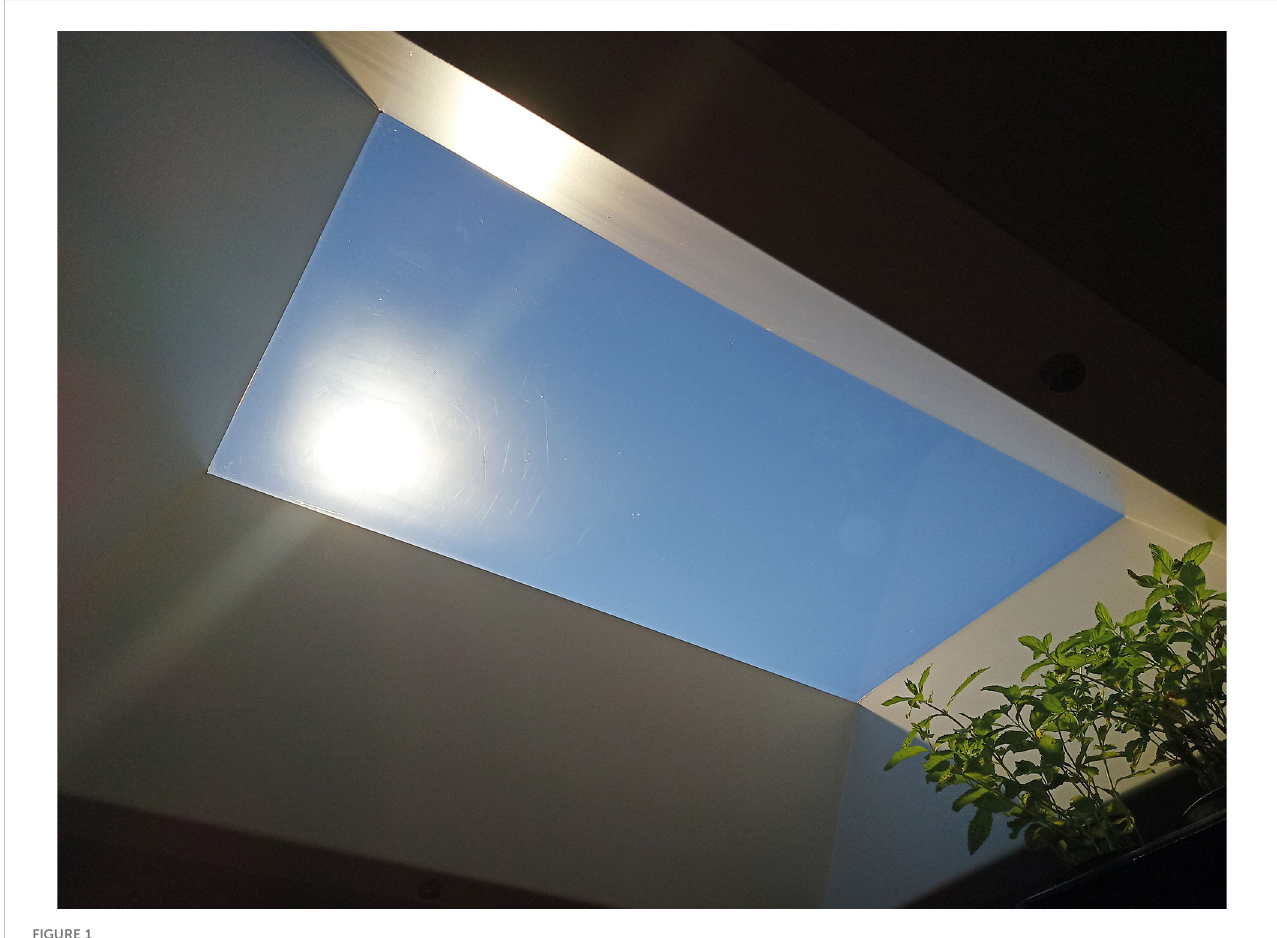
FIGURE 1 The visual appearance of the CoeLux ® lighting